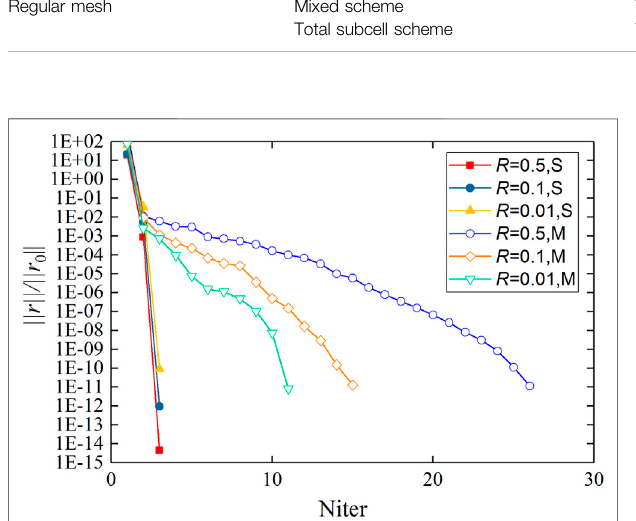
FIGURE 15 | Convergence pro fi les of two integration schemes with differentpartitionratios (Sdenotestotal subcellschemeandMdenotesmixed